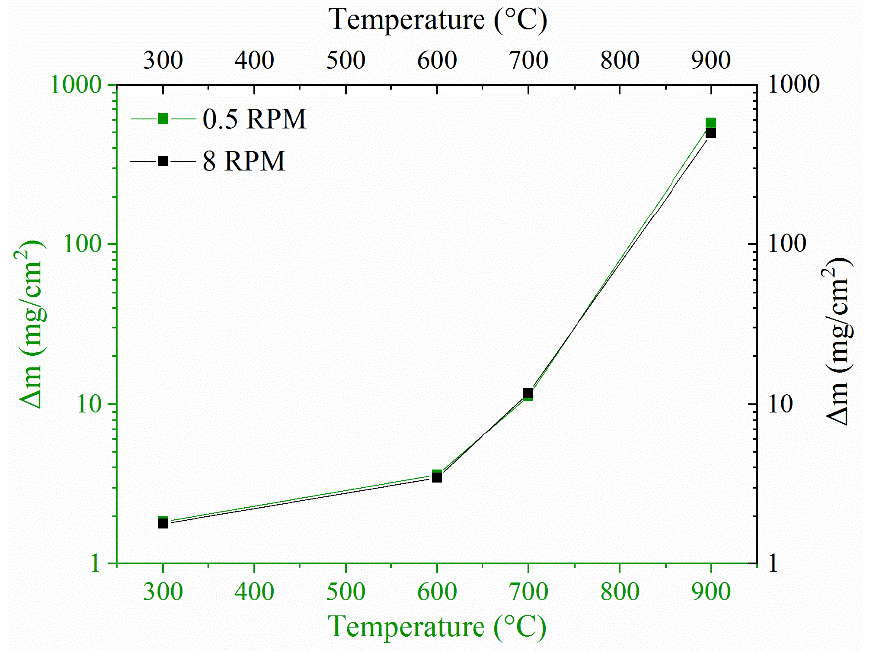
Figure 2. The mass gains due to oxidation for samples obtained using 0.5 RPM and 8 RPM deposition regimes.